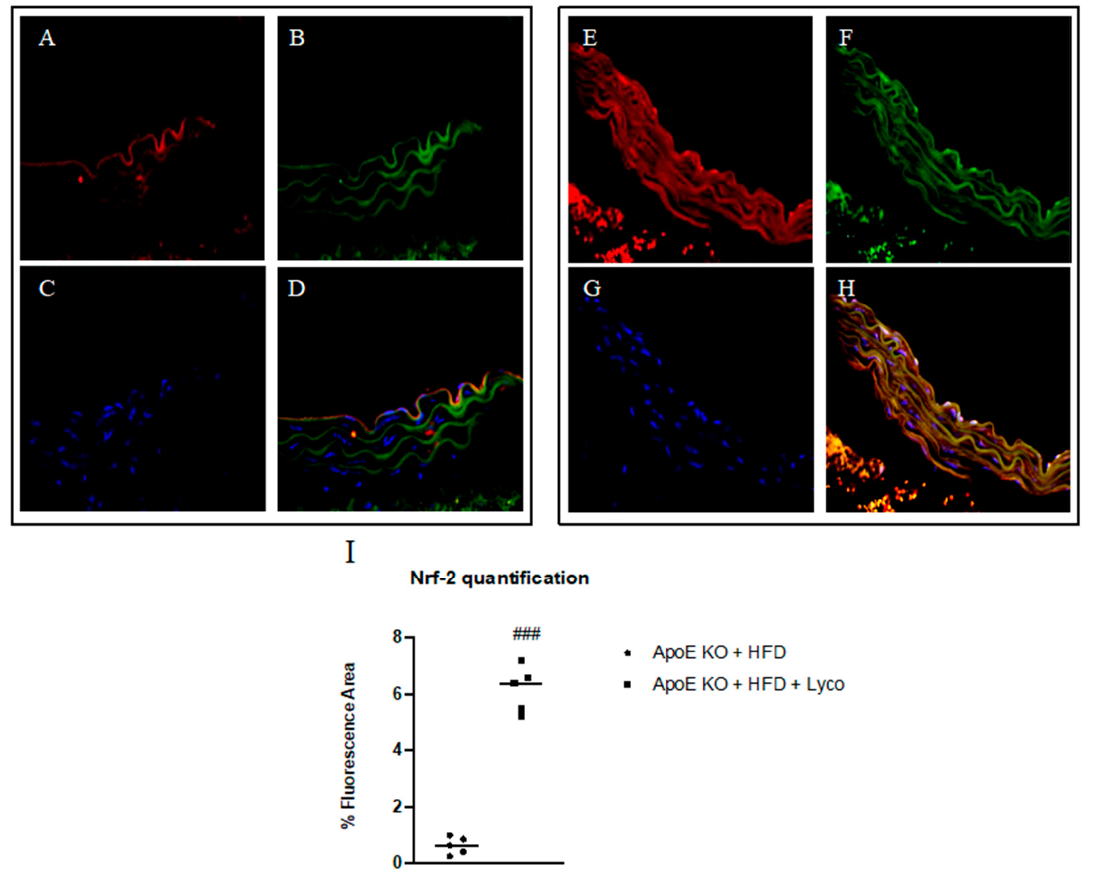
Figure 4. Immunofluorescence staining for Nrf2 (red channel, ( A , E )) and CD34 (green channel, ( B , F )) in aorta samples of ApoE KO + HFD and ApoE KO + HFD + Lycopene mice. The merge signal shows the co-localization of Nrf2 in CD34+ cells ( D , H ). Panels ( C , G ) showed nuclei stained with DAPI. The graph in ( I ) shows the quantification of Nrf2 expression performed with Image-J. Values are expressed as the mean ± SD of 5 animals. ### p < 0.0001 vs. ApoE KO + HFD.